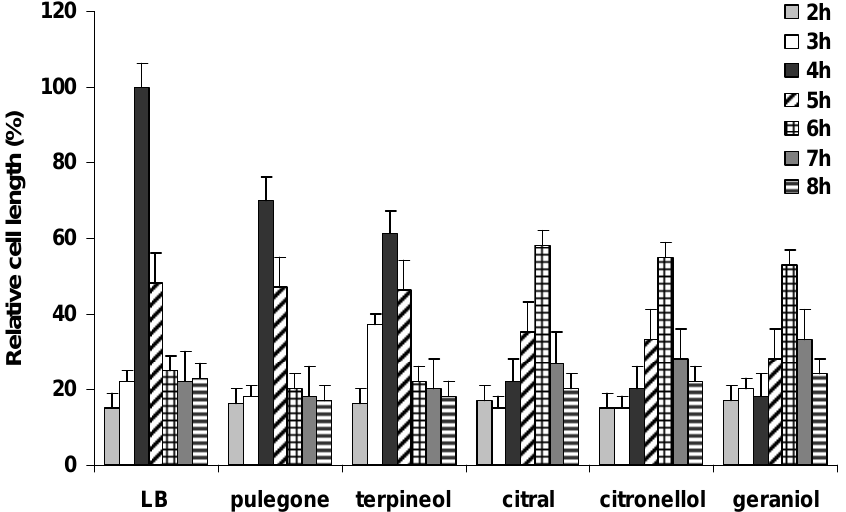
Figure 5. Effect of selected monoterpenes on the cell length of P. mirabilis L68. The concentration of monoterpenes added were 0.3 mg/L for citronellol and geraniol, and 0.5 mg/L for citral, pulegone and α -terpineol. Data represent the average of three independent